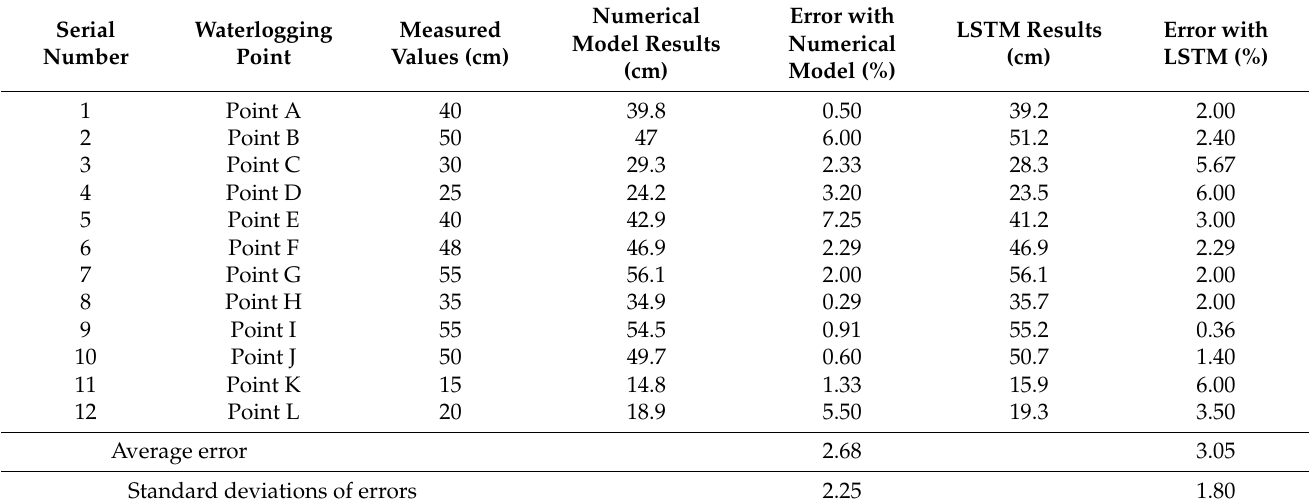
Table 2. Comparison between the maximum ponding depths predicted by the numerical model and long short-term memory (LSTM) model and the measured